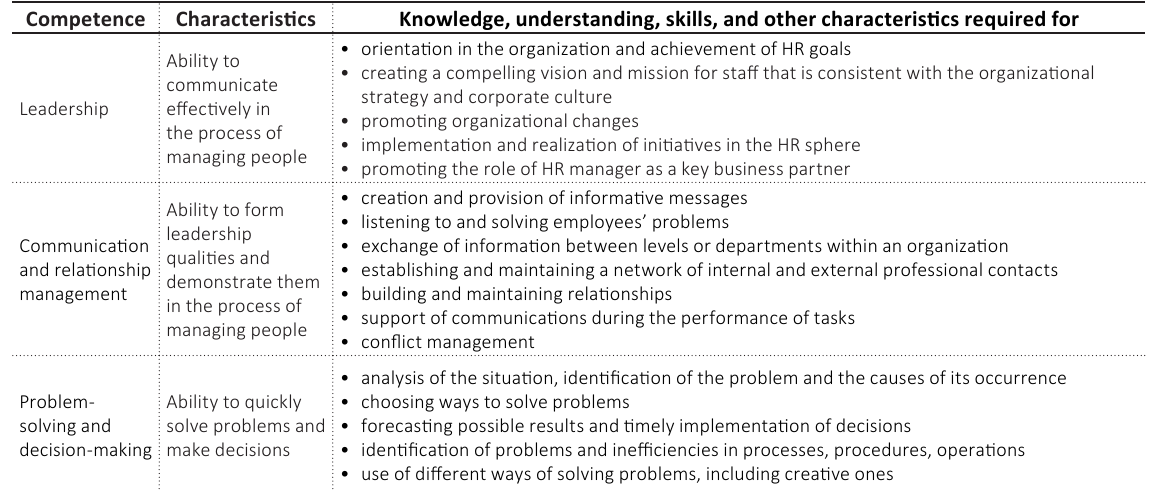
Table 1. Transferable competencies of personnel